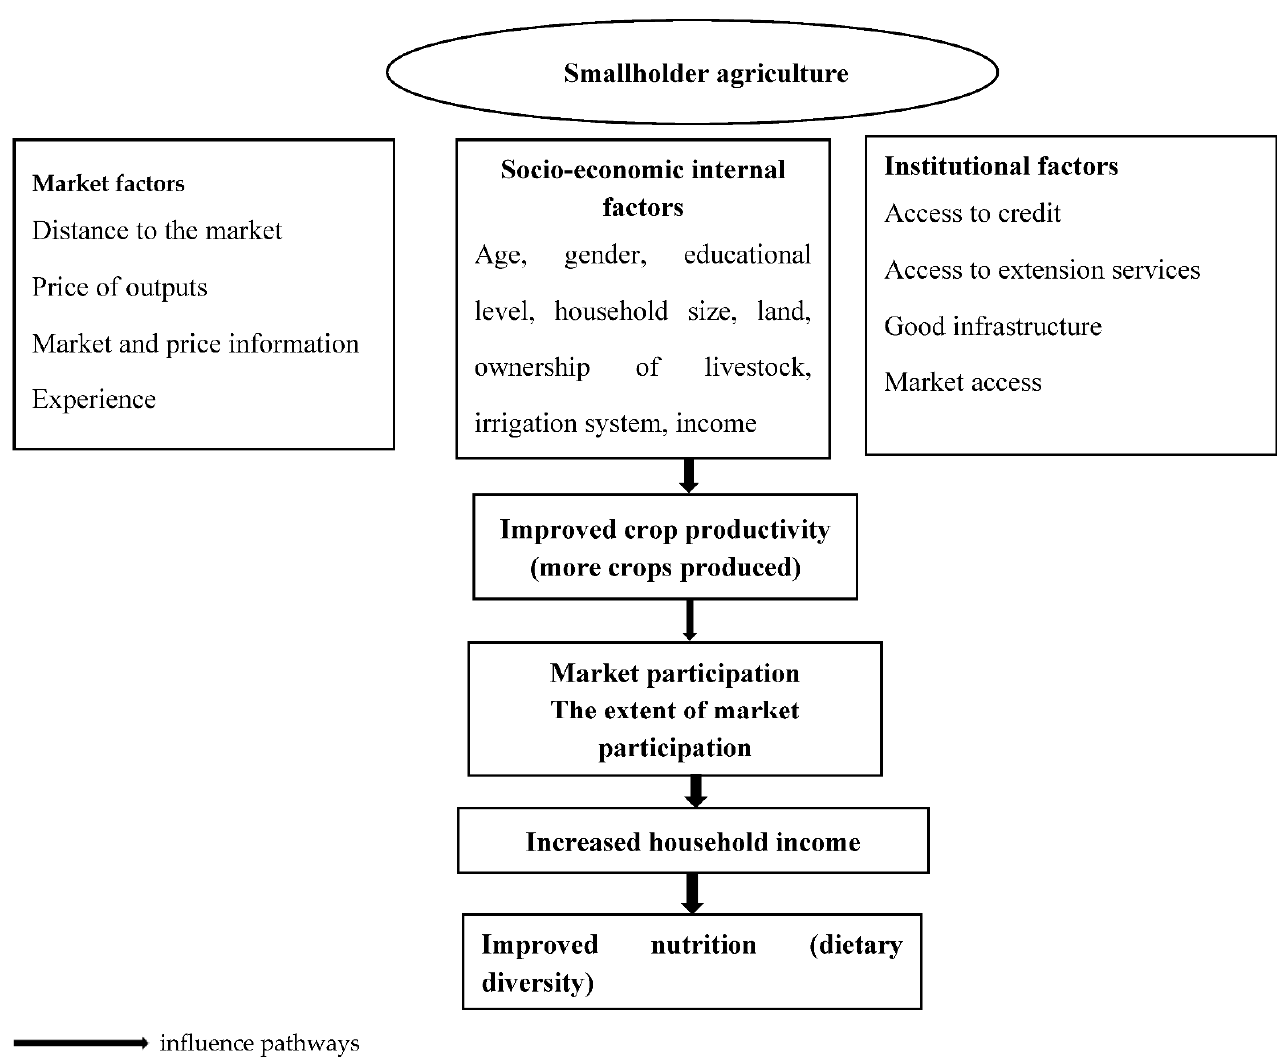
Figure 1. Diagrammatic representation of the conceptual framework.